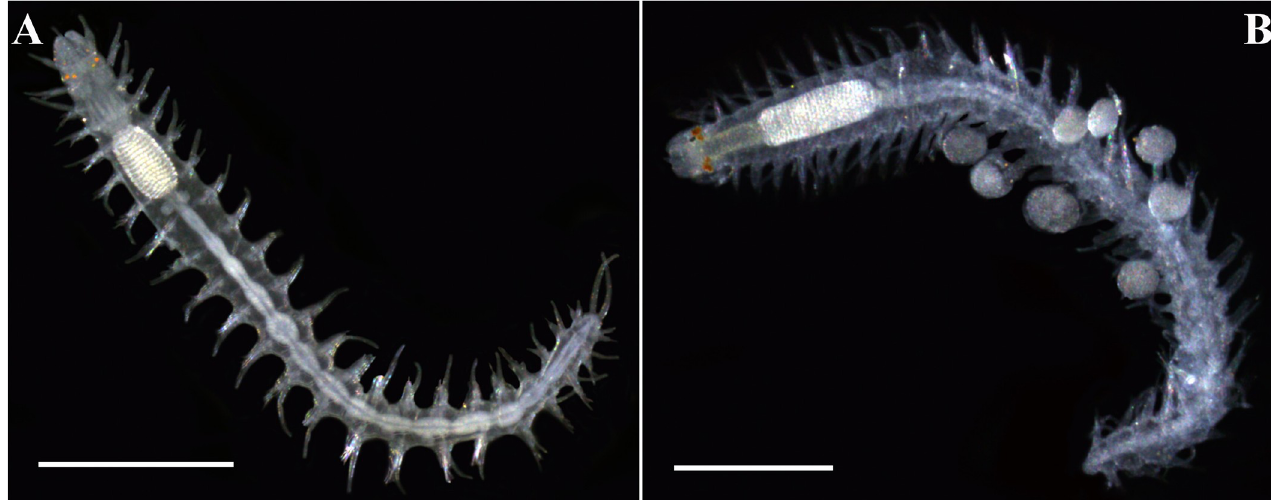
Fig 6. Photographs of the holotypes. (A). Salvatoria marielleae n. sp. , entire body, dorsal view; (B). Salvatoria ypsiloides n. sp. brooding eggs dorsally, entire body, dorsal view. Scale bars: A, 0.5 mm; B, 0.3 mm.